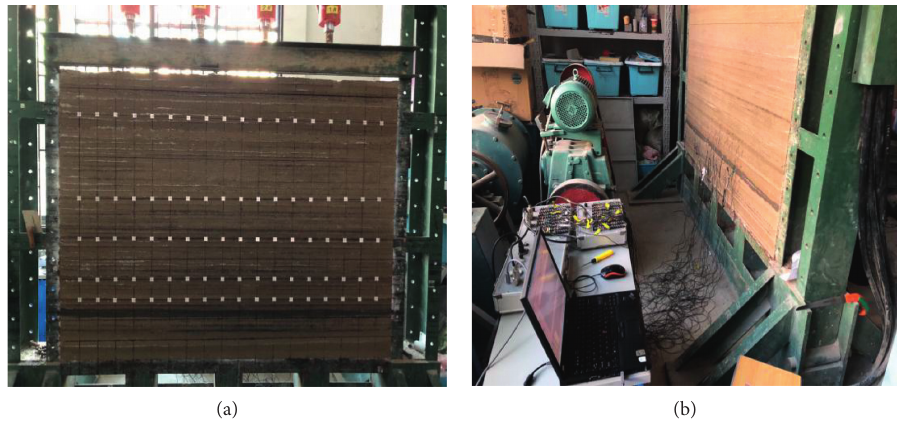
Figure 7: Laboratory equipment.